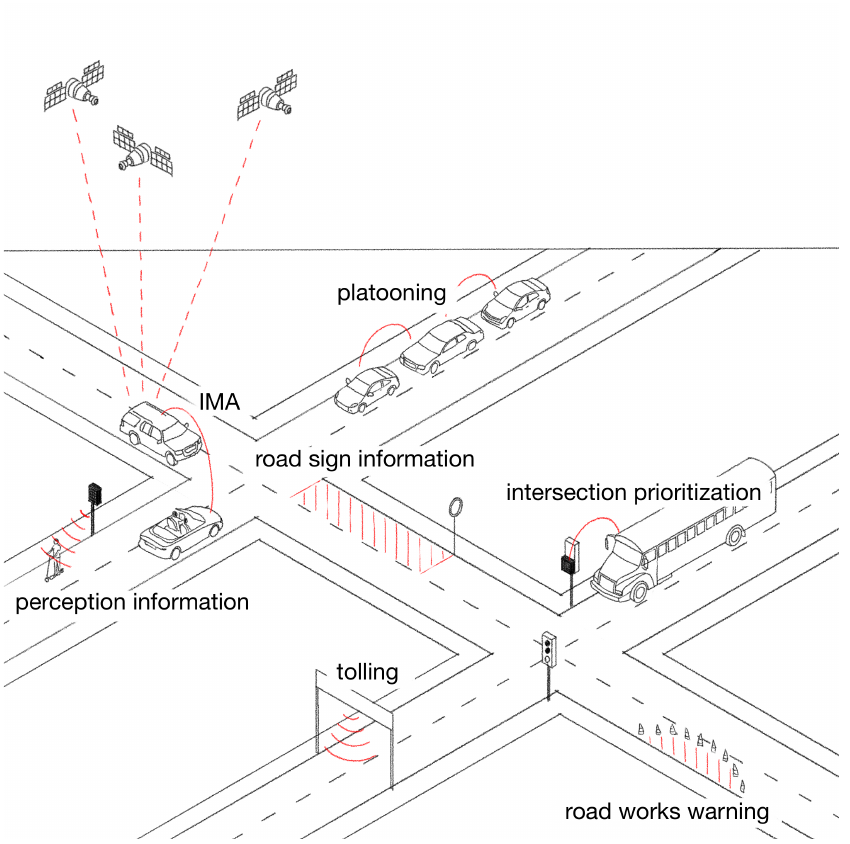
Figure 1. Intelligent transport systems: a generic view with example use